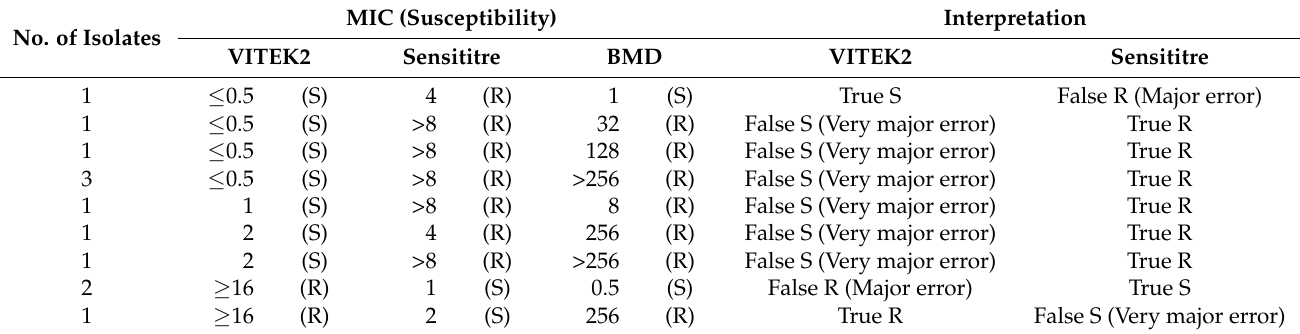
Table 5. Discordant results of the VITEK2 and Sensititre